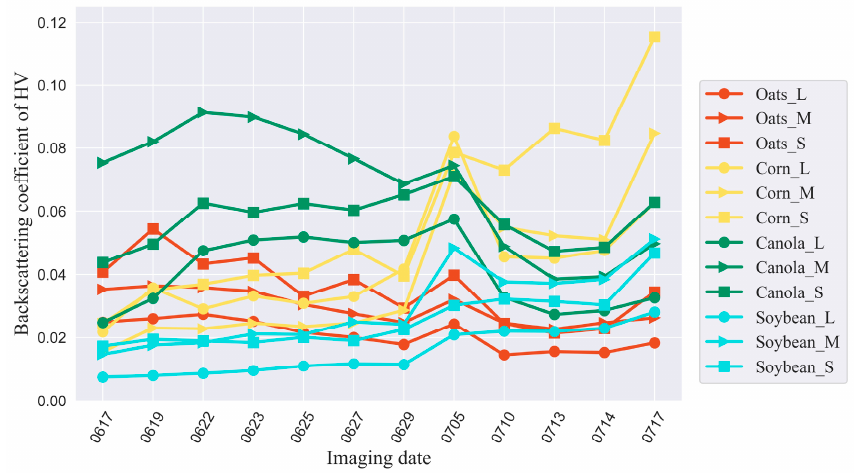
Figure 7. Time-series curves of the crops in different regions. “_L” denotes that the crop is from the region of Inc_L, “_M” denotes that the crop is from the region of Inc_M, and “_S” denotes that the crop is from the region of Inc_S.